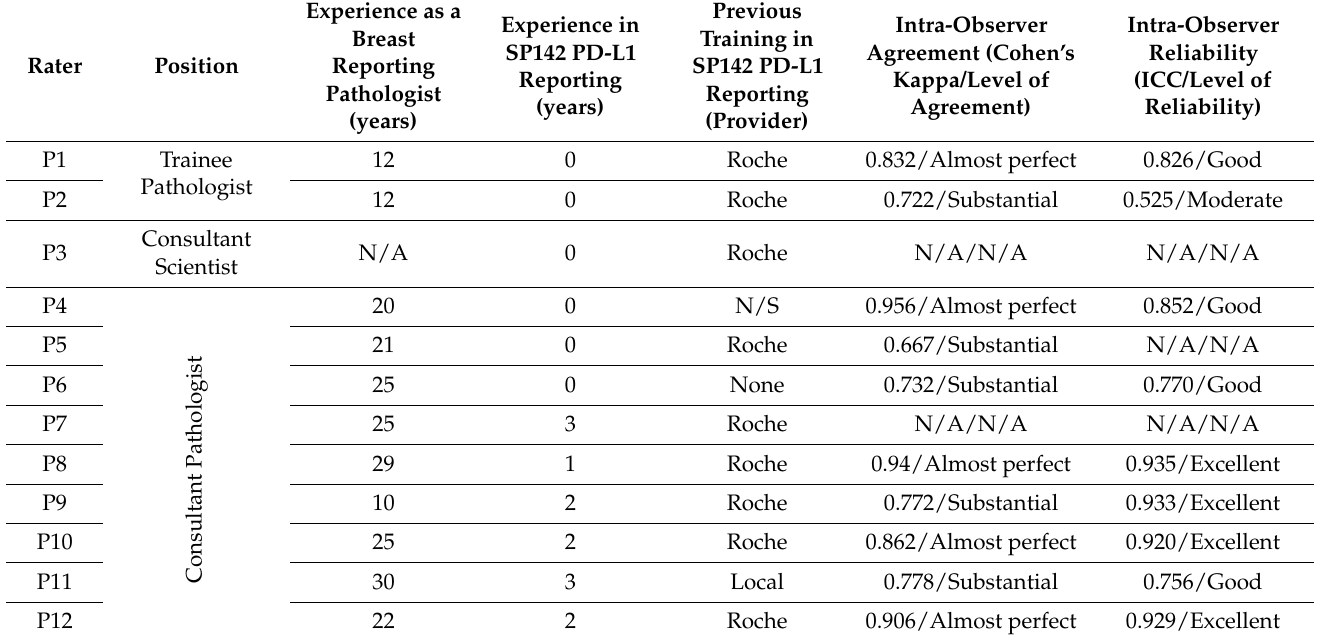
Table 8. Intra-observer concordance based on pathologists’ experience in scoring